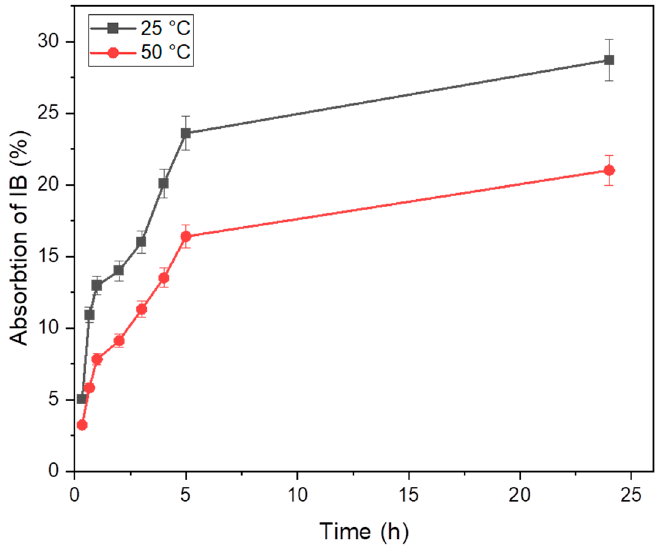
Figure 8. Optimization of temperature for the absorption of IB.